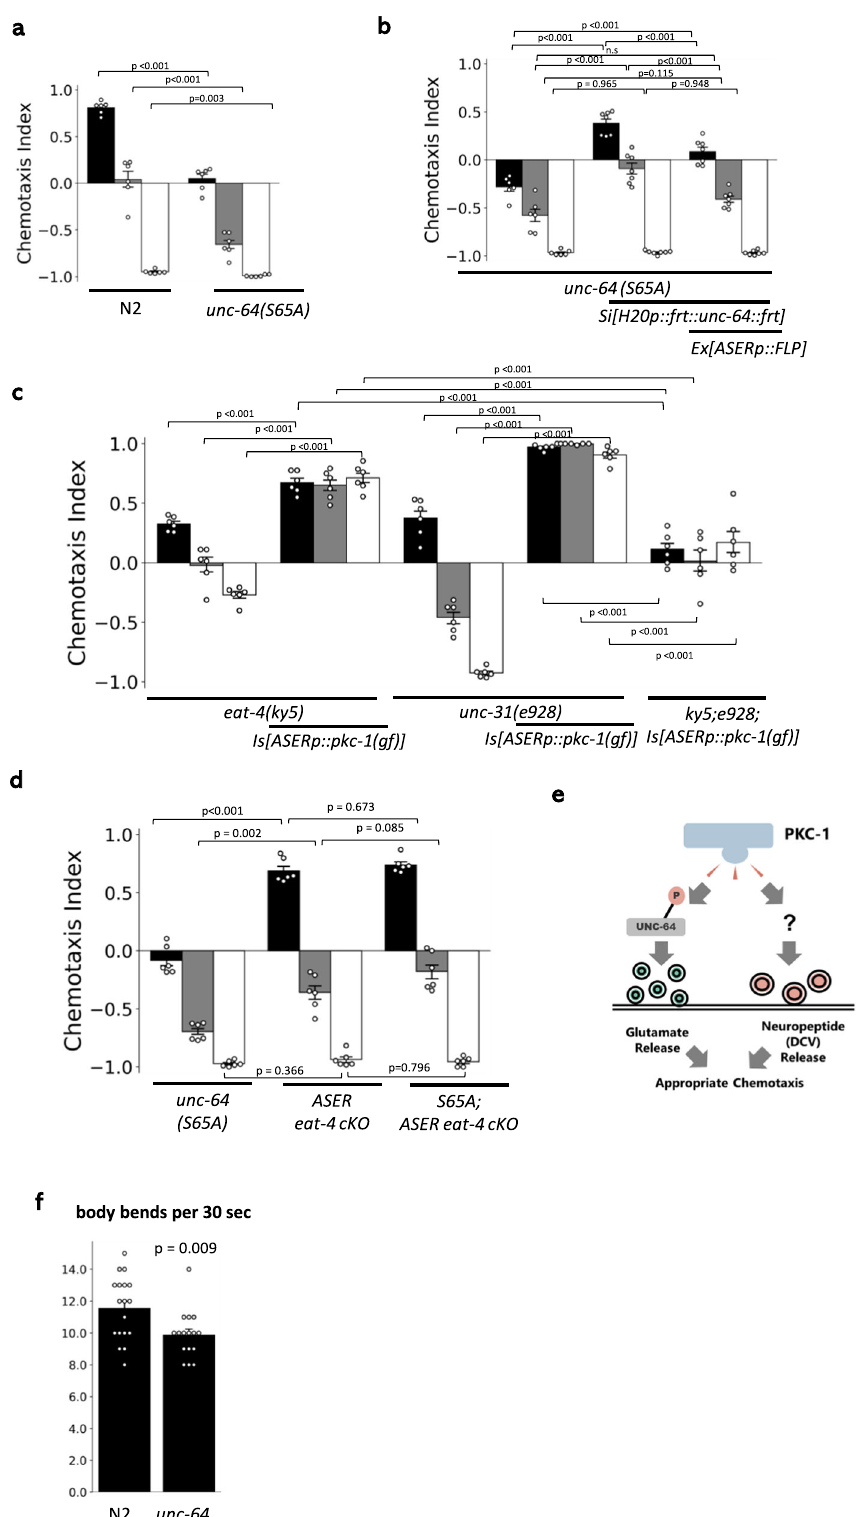
AIB exhibited excitatory responses when observed with calcium probe GCaMP6s (Fig. 5f). These results suggest that the decreased glutamate release from ASER in pkc-1(nj3) or unc-64(S65A) mutants is decoded as the reversed response of AIB to NaCl. Moreover, considering that AIB controls reorientation behavior, the direction of AIB response to NaCl decrease, either excitatory or